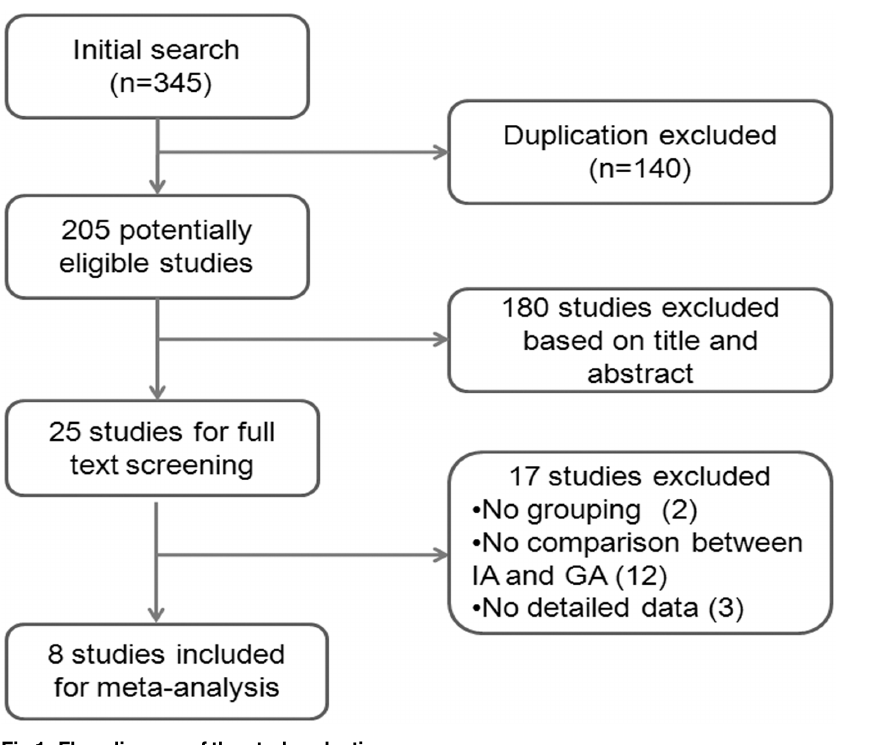
Fig 1. Flow diagram of the study